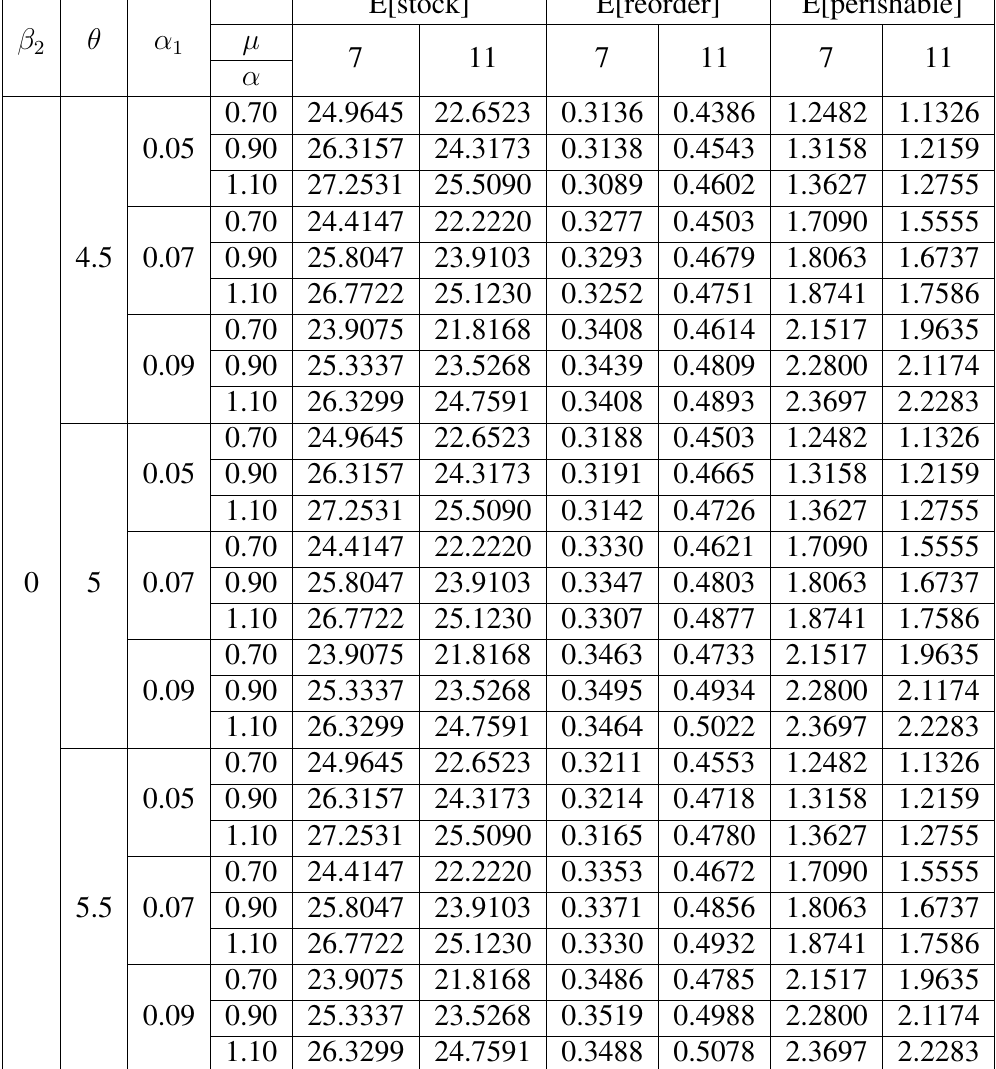
Table 5: Impact of E[psl], E[reorder and E[perishable] with the parameter variation β